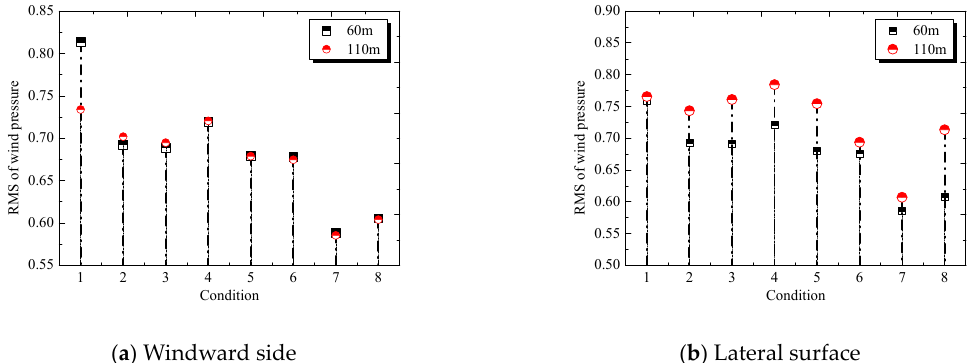
Figure 16. Distribution of RMS of wind pressure in the undisturbed zone and the disturbed zone under different conditions.